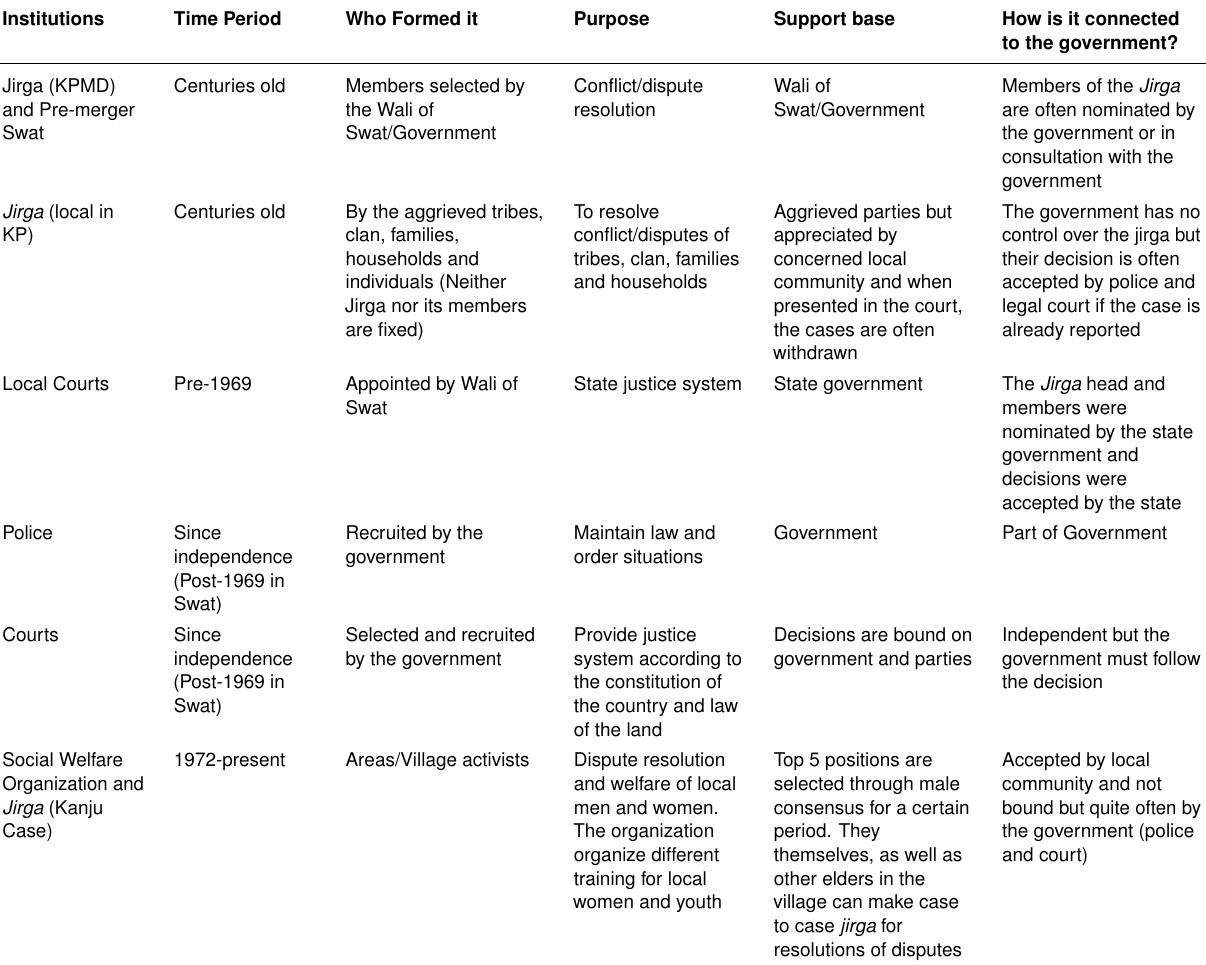
Table 1. Civil Society and Government Security and Conflict Resolution Institutions in